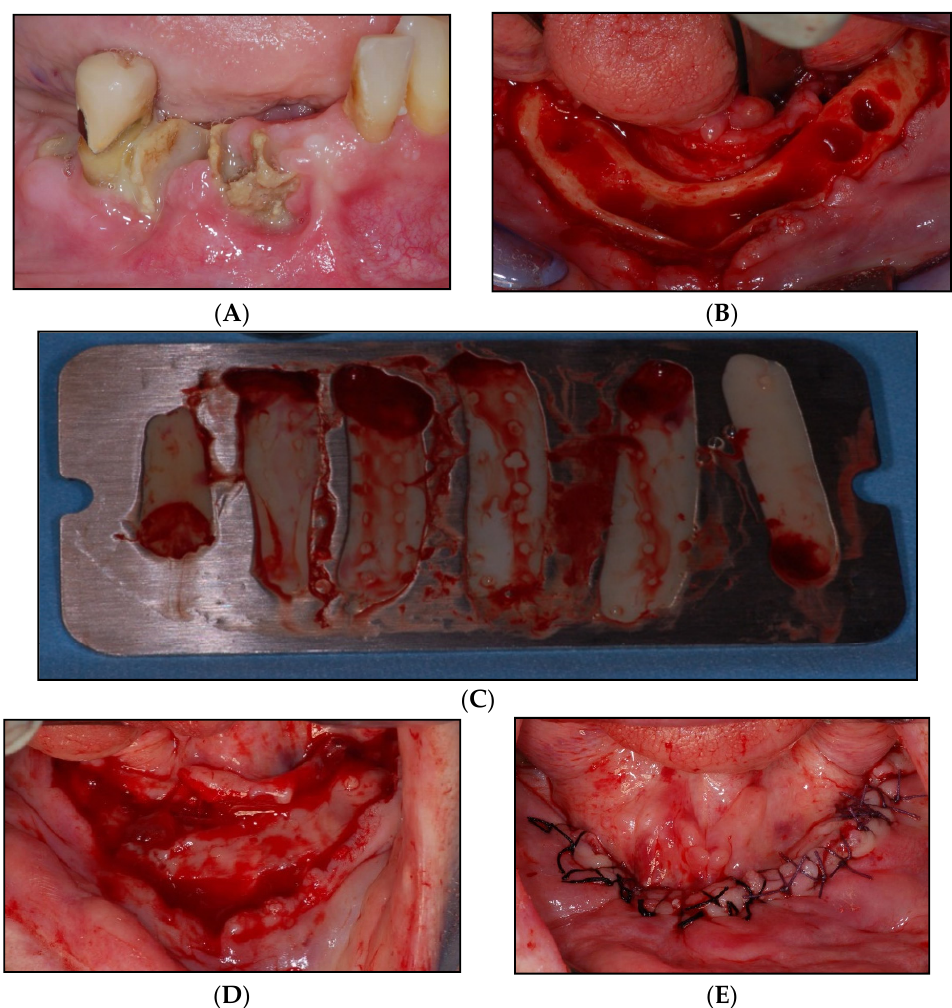
Figure 1. Exemplary surgical procedures in study arm ( B ): ( A ) Preoperative situation with MRONJ stage II of the right mandible with exudation of pus. ( B ) Intraoperative situation after tooth extraction and decortication. ( C ) Pressed PRF. ( D ) PRF covering the decorticated bone. ( E ) Mechanically stable covering with soft tissue.